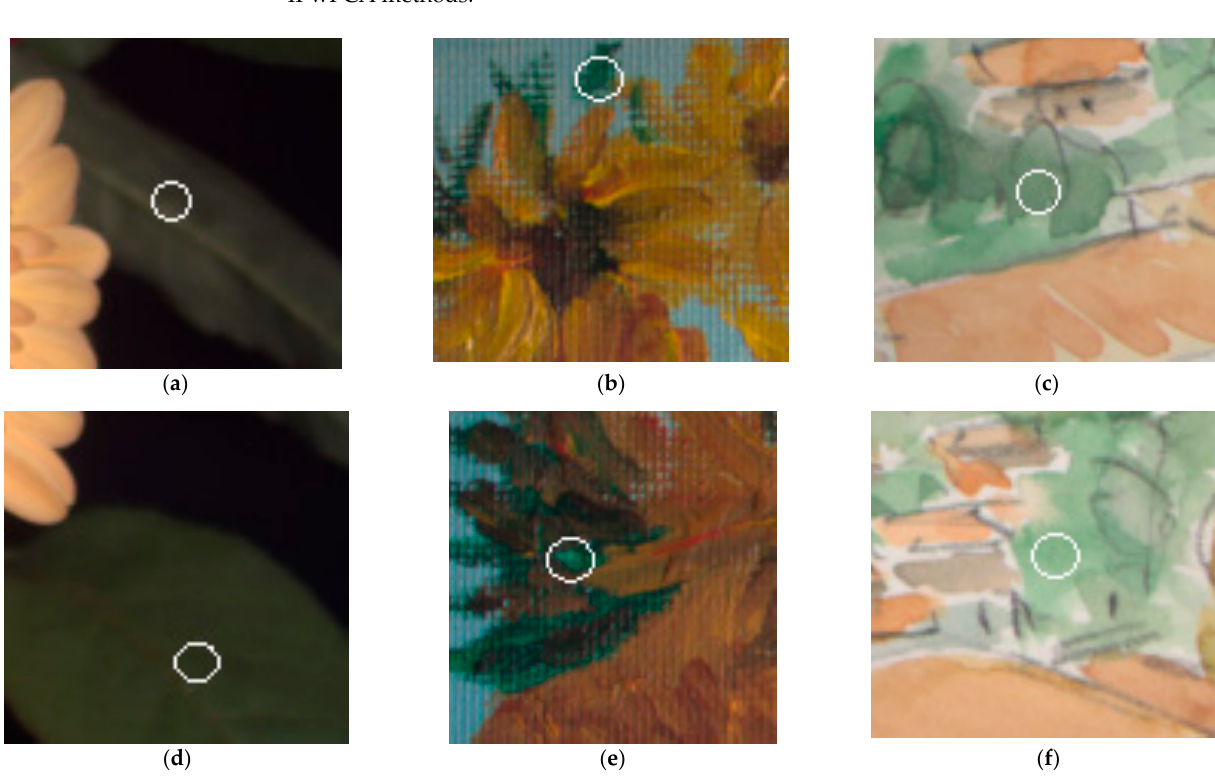
Figure 22. ( a – f ) showing enlarged leaf images. ( a , d ) are in Figure 20a (“flowers”). ( b , e ) are in Figure 15b (“oil painting”). ( c , f ) are in Figure 15a (“watercolors”). The center of the white circle was an example pixel showing the recovered spectral reflectance.